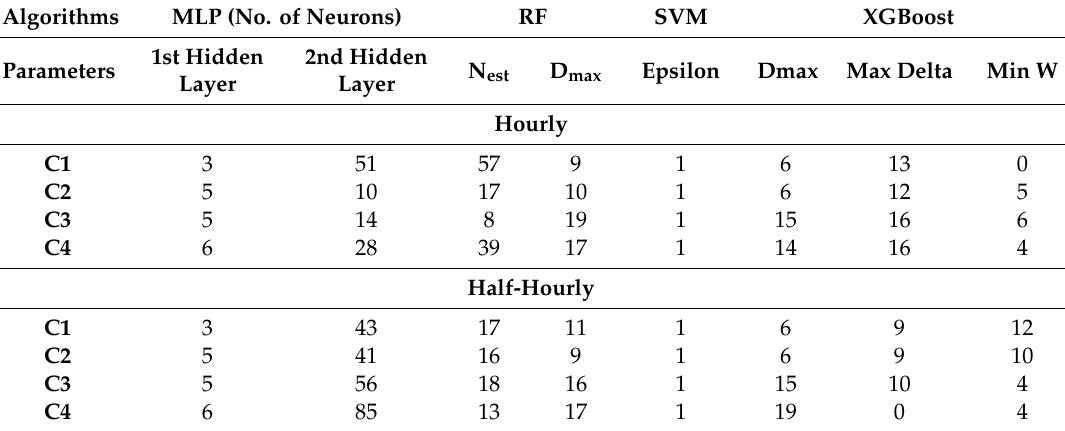
Table A1. Optimized model parameters of agro-forested (AgF) hillslope.